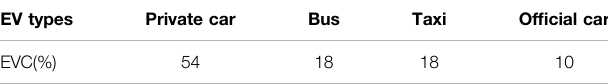
TABLE 4 | EVC proportion of various types of electric